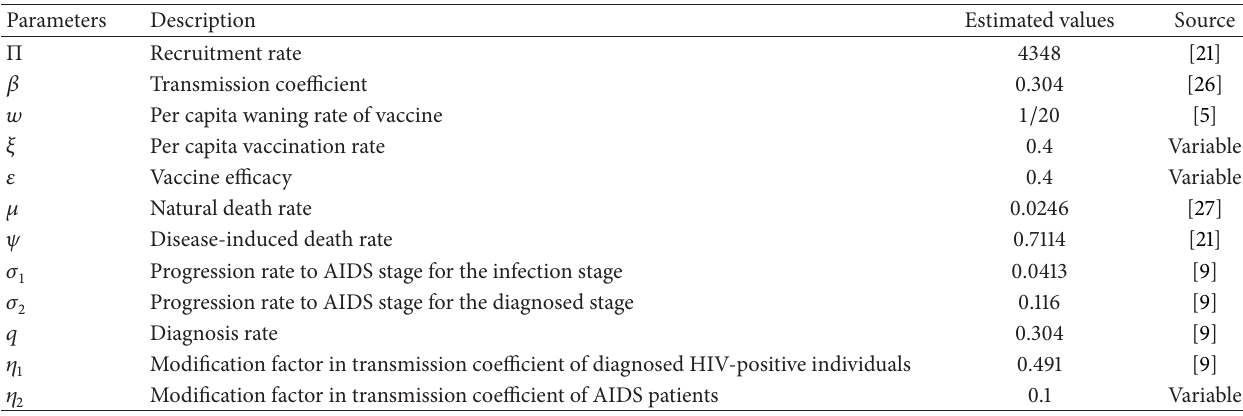
Table 1: Parameter description and